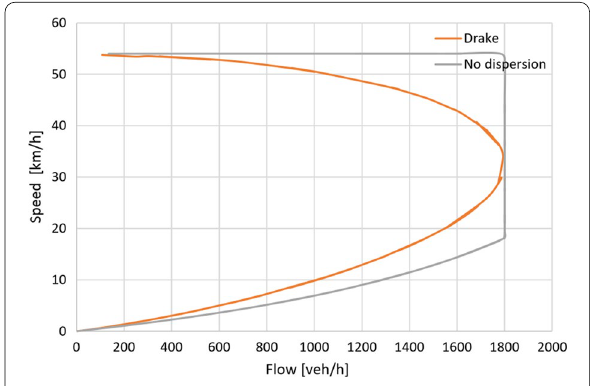
Fig. 4 fundamental diagram: speed—flow